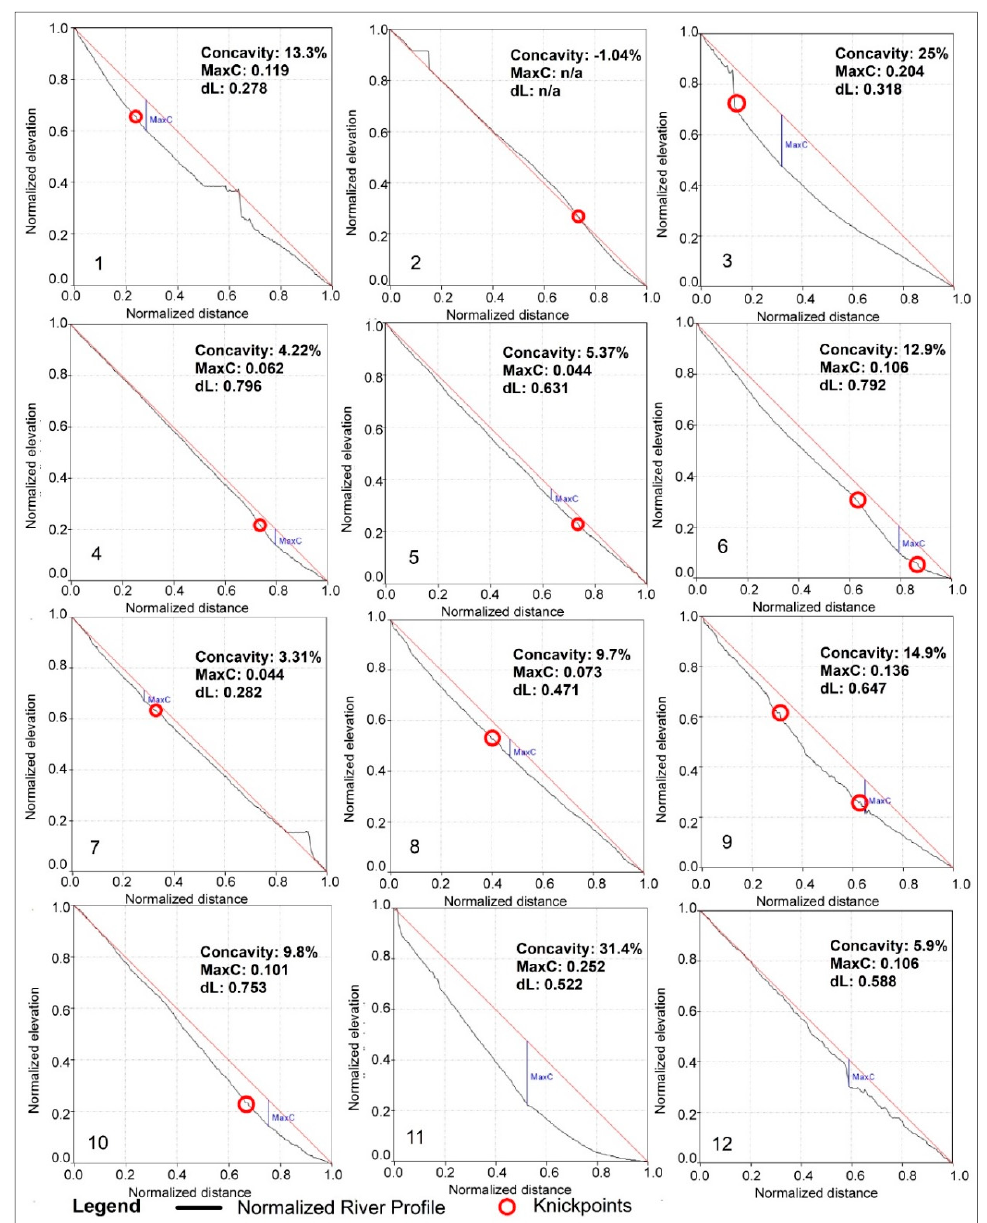
Figure 9. Normalized longitudinal river profiles in the study area. The shape of profiles varies from linear to convex with a maximum concavity of 35%. These profiles represent unstable young basins. The knickpoints shown are in agreement with the Ksn and the maximum curvature; MaxC: maximum concavity, MaxL: distance where the maximum concavity occurs.